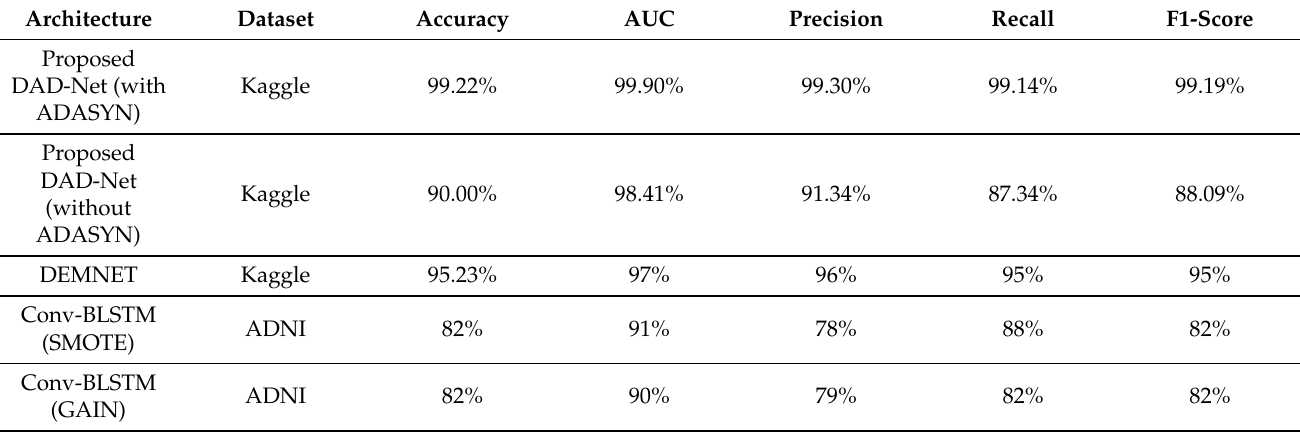
Figure 20. Generalization of the class activation map to locate the discriminative region through Grad-CAM. Table 3. Performance comparison of proposed CNN Model and other state-of-the-art